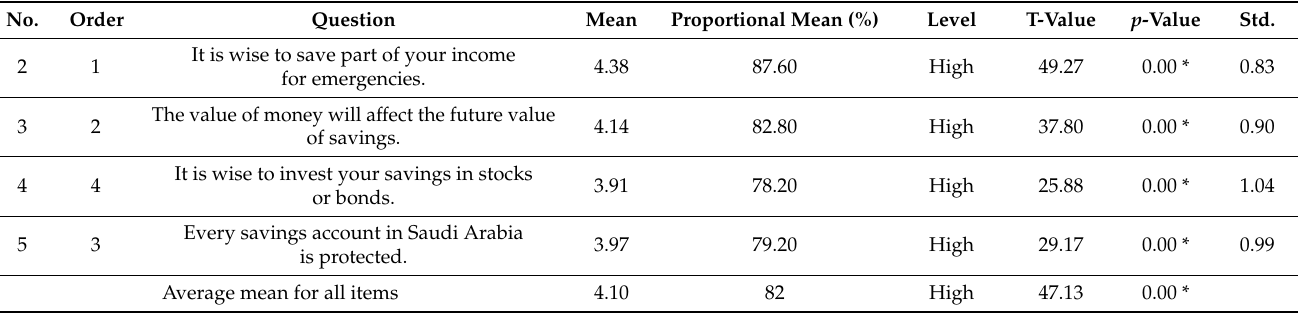
Table 7. Saving: Mean and std. values for financial literacy levels ( n = 887).